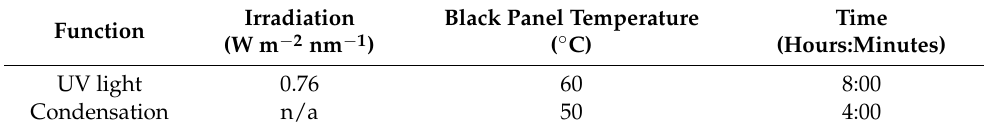
Table 2. UV test cycles